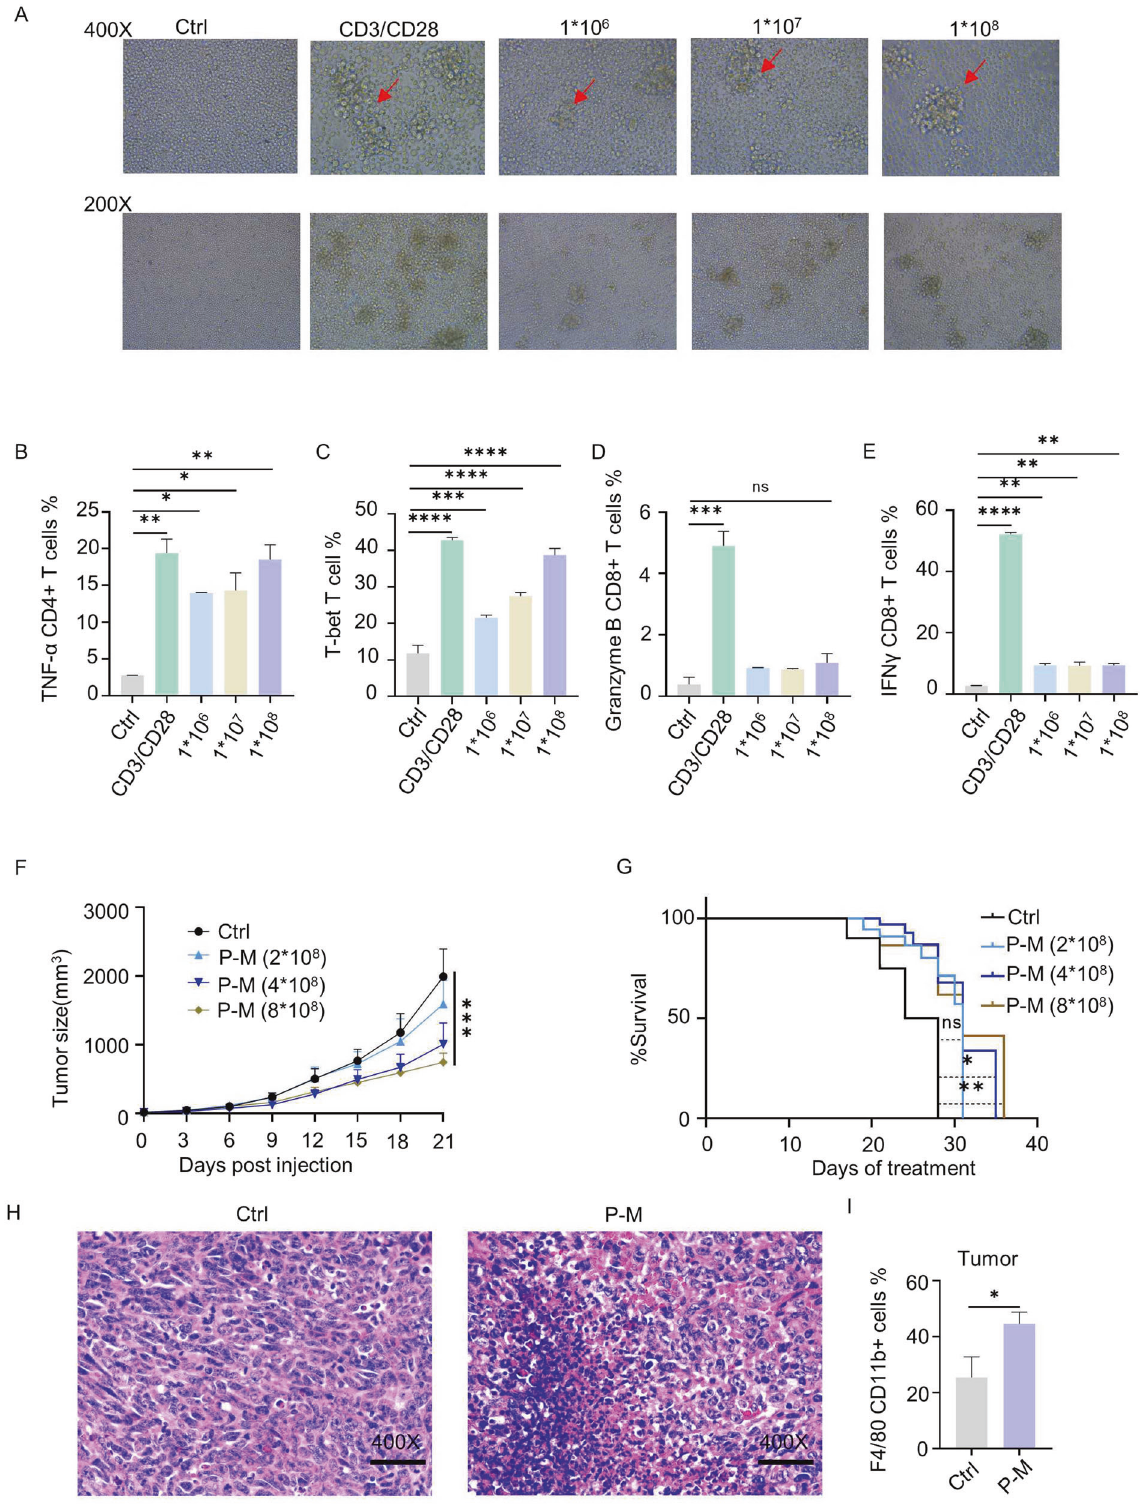
Fig. 2 PA-MSHA increased tumor in fi ltrating immune effector cells and inhibits tumor growth in vivo. A T cells were activated by PA-MSHA at 72 hours, original magni fi cation, ×400 and ×200. B TNF- α of CD4 + T cells ( C ) T-bet in T cells ( D ) Granzyme B in CD8 + T cells E IFN- γ levels in CD8 + T cells were all signi fi cantly increased by PA-MSHA. F In vivo assay, PA-MSHA inhibited tumor growth in a dose dependent manner. G PA- MSHA prolonged the survival time of tumor-bearing mice. H H&E analysis showed that PA-MSHA (4 × 10 8 pcs/ml) induced more immune cells in fi ltration in tumor tissue. Original magni fi cation, ×400. ( I ) Flow-cytometry data showed that the number of macrophages in LLC tumors was signi fi cantly upregulated by PA-MSHA. P-M is short for PA-MSHA. ( n = 6 mice/group, * P < 0.05, ** P < 0.01, *** P < 0.001, **** P < 0.0001.).